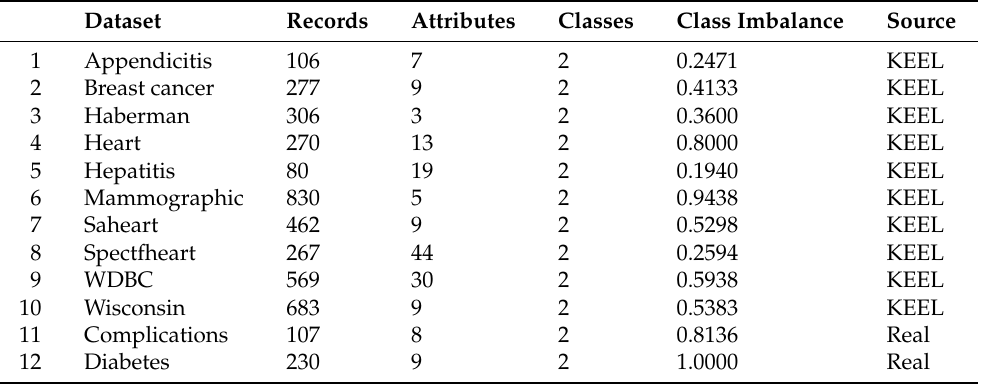
Table 1. Summary of datasets used in